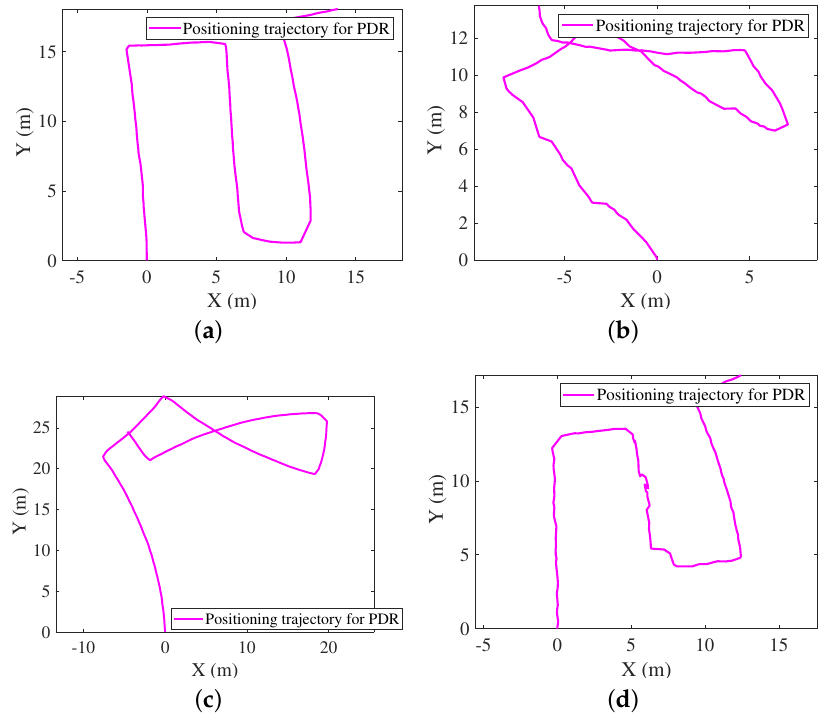
Figure 4. Navigation trajectories for PDR. ( a ) Calling mode. ( b ) Dangling mode. ( c ) Handheld mode. ( d ) pocketed